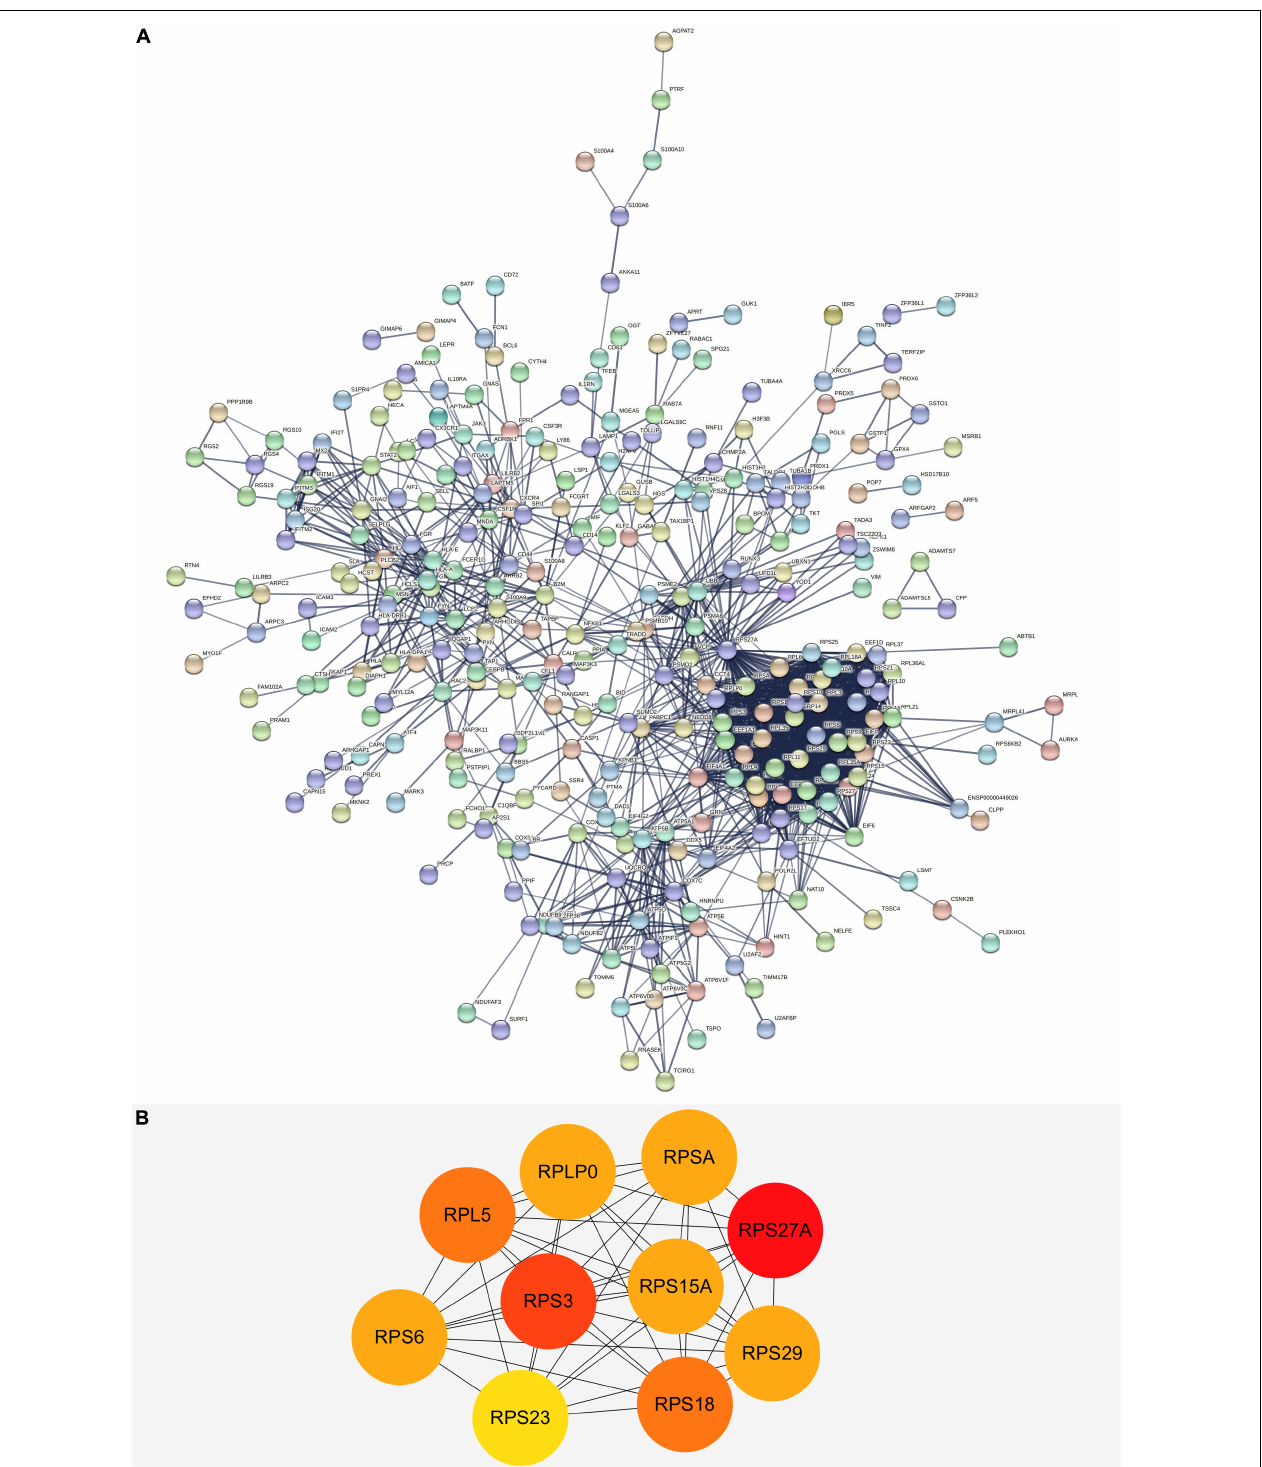
FIGURE 6 | (A) The PPI network of DEGs in AD. There are a total of 308 nodes and 3,244 edges. Nodes represent proteins and edges represent interactions between proteins. (B) The top 10 hub genes with higher degree screened from a PPI network according to the Degree algorithm. Darker color indicates degree. PPI, protein-protein interaction; DEGs, differentially expressed